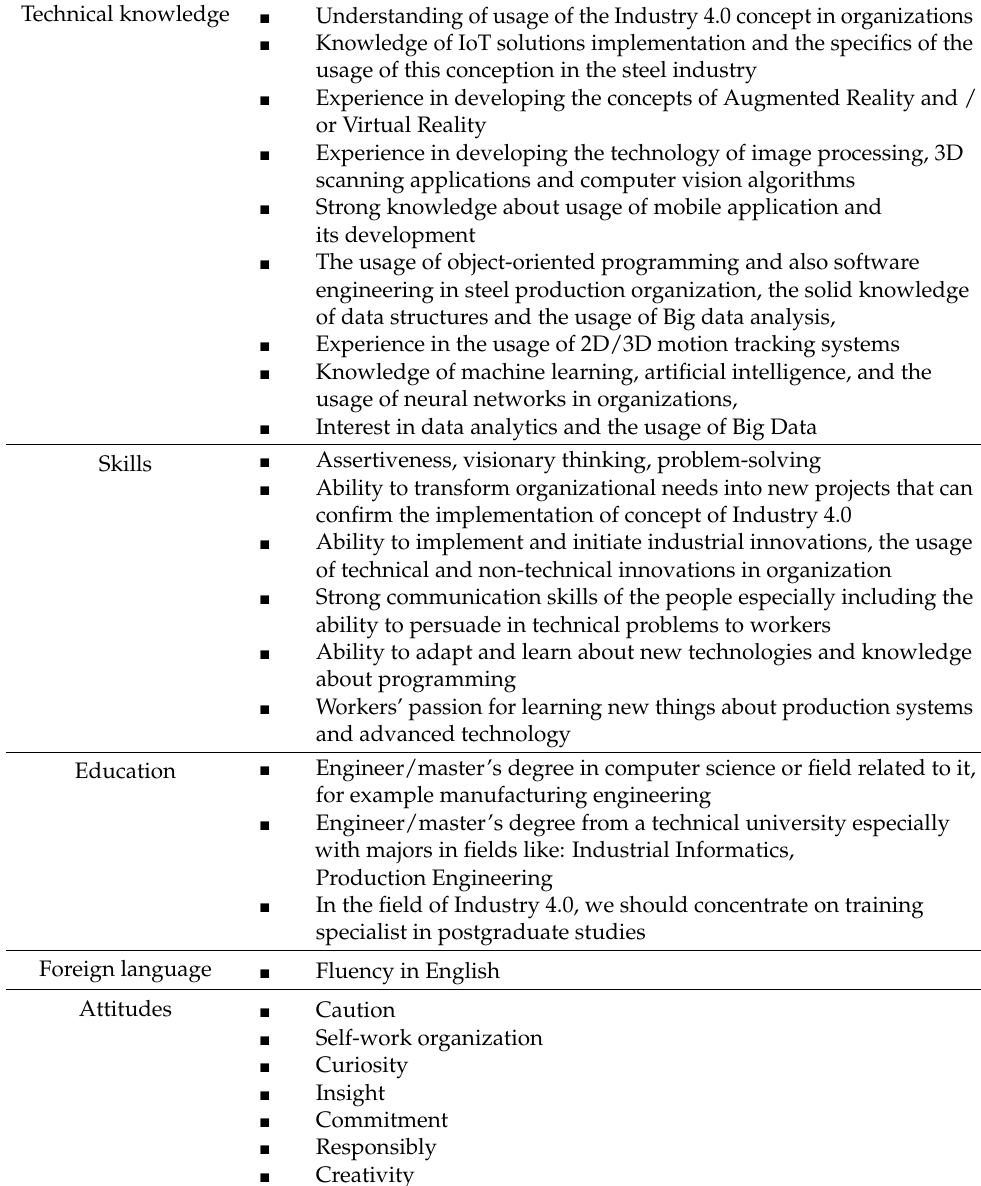
Table 5. Portfolio of professional qualifications of employees in a steel company. Technical